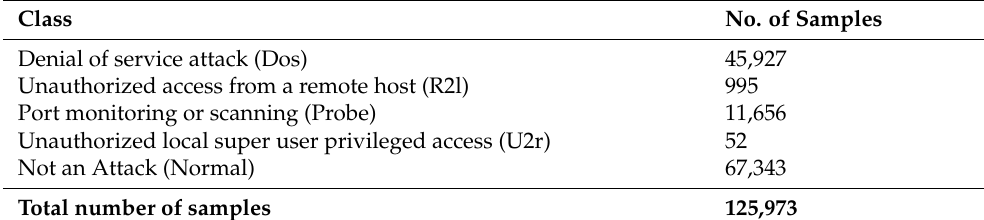
Table 1. Details of the